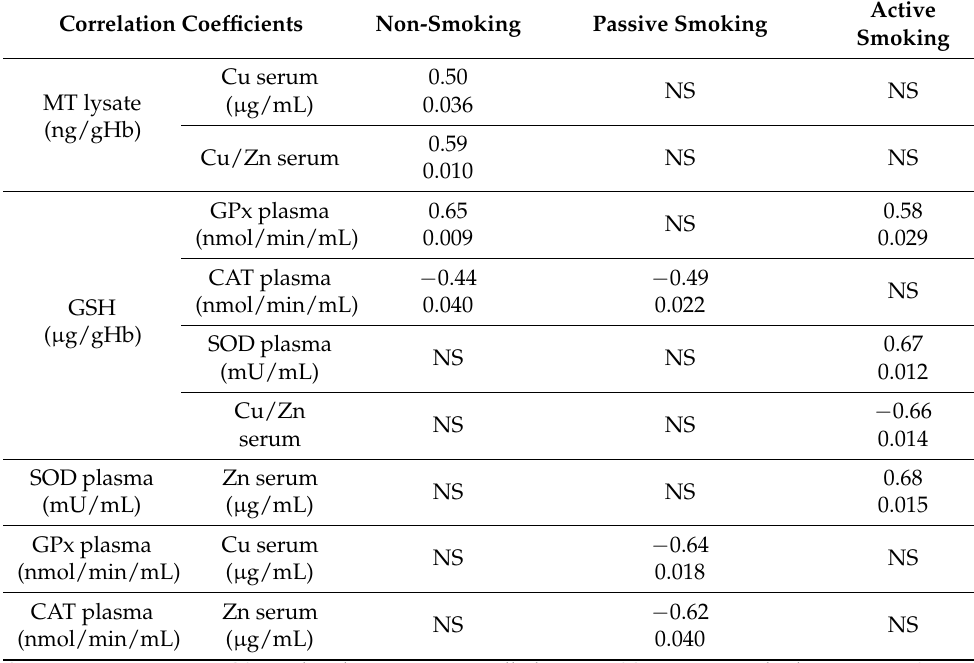
Table 6. Significant correlation coefficients in the group of pregnant